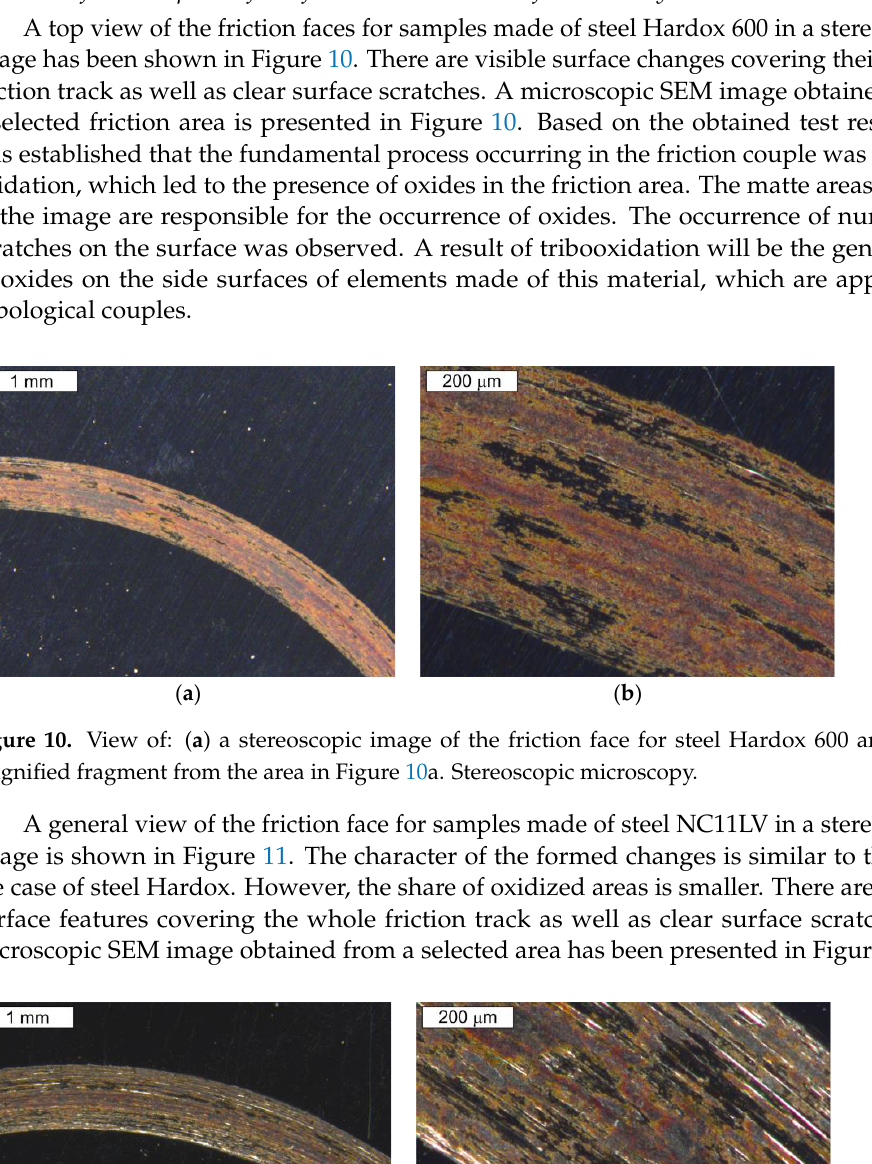
Figure 9. Coefficients of friction in a ball-on-disc trial for both analyzed materials.